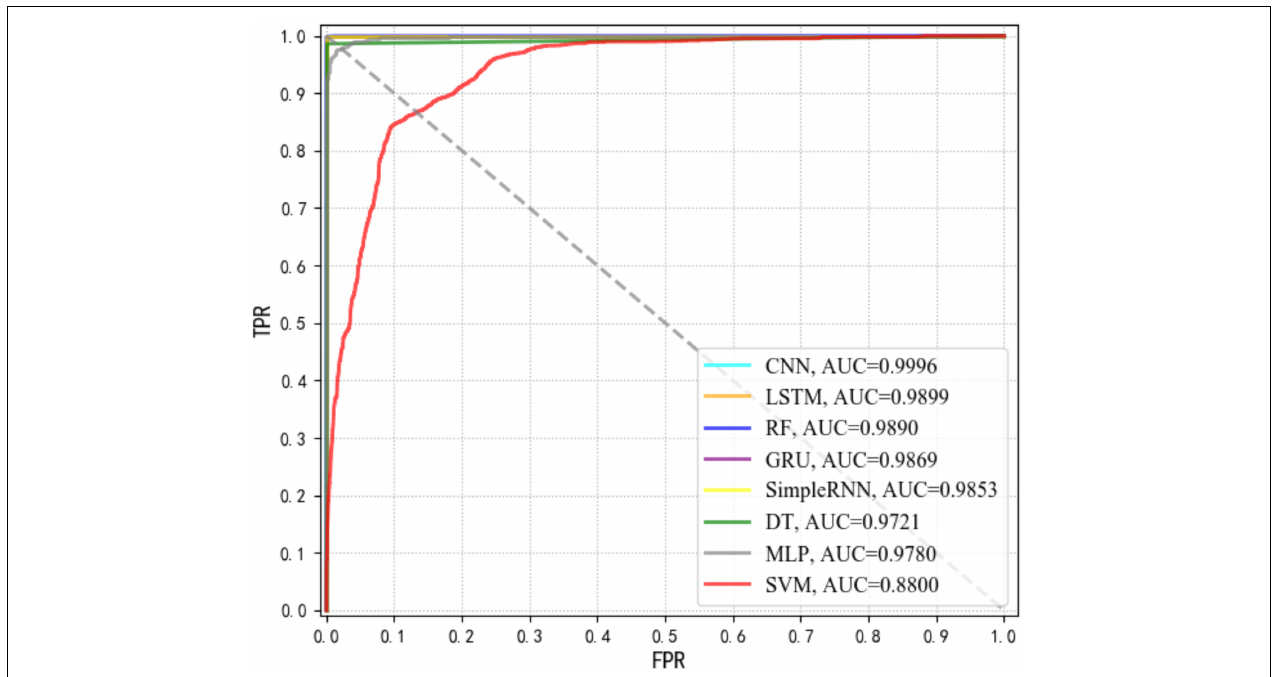
FIGURE 4 | Comparison of receiver operating characteristic curve (ROC) curves via area under the curve (AUC) values for eight supervised machine learning